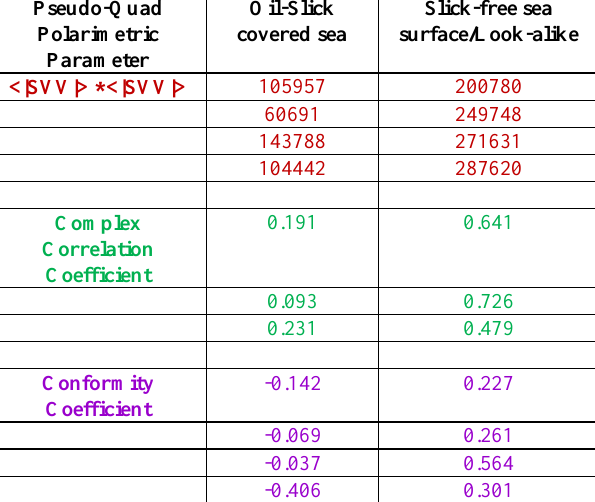
Table 3: Pseudo-Quad Polarimetric Parameters derived